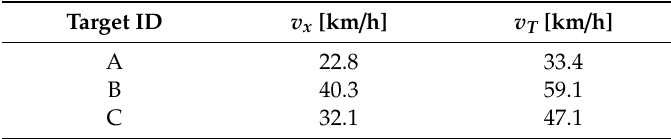
Table 2. Velocity of three detected moving vehicles at Baishazhou Bridge on 13 July 2016. Refer to Figure 9 for locations.